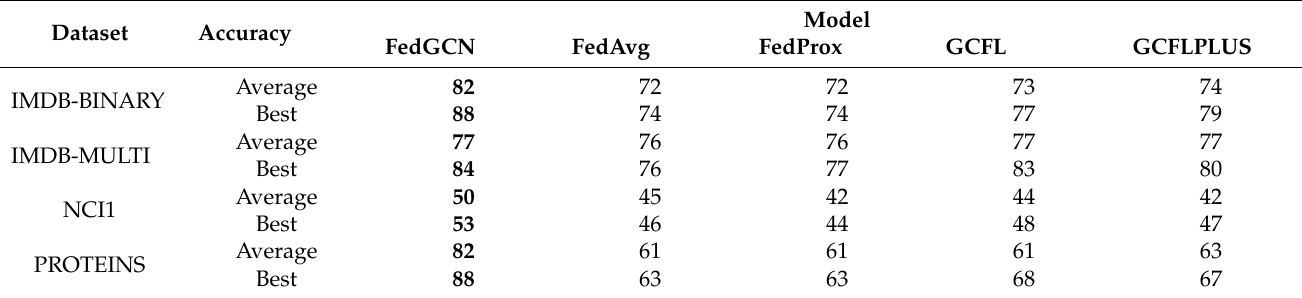
Table 3. Comparison of the accuracy of federated learning global models (%).